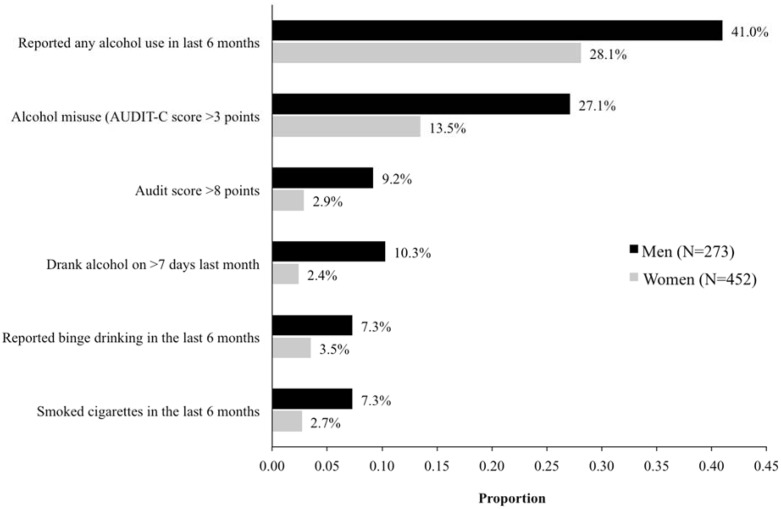
Proportions of men and women reporting different alcohol and smoking outcomes among 725 HIV-infected individuals attending the Infectious Disease Institute HIV Clinic, Kampala, Uganda.